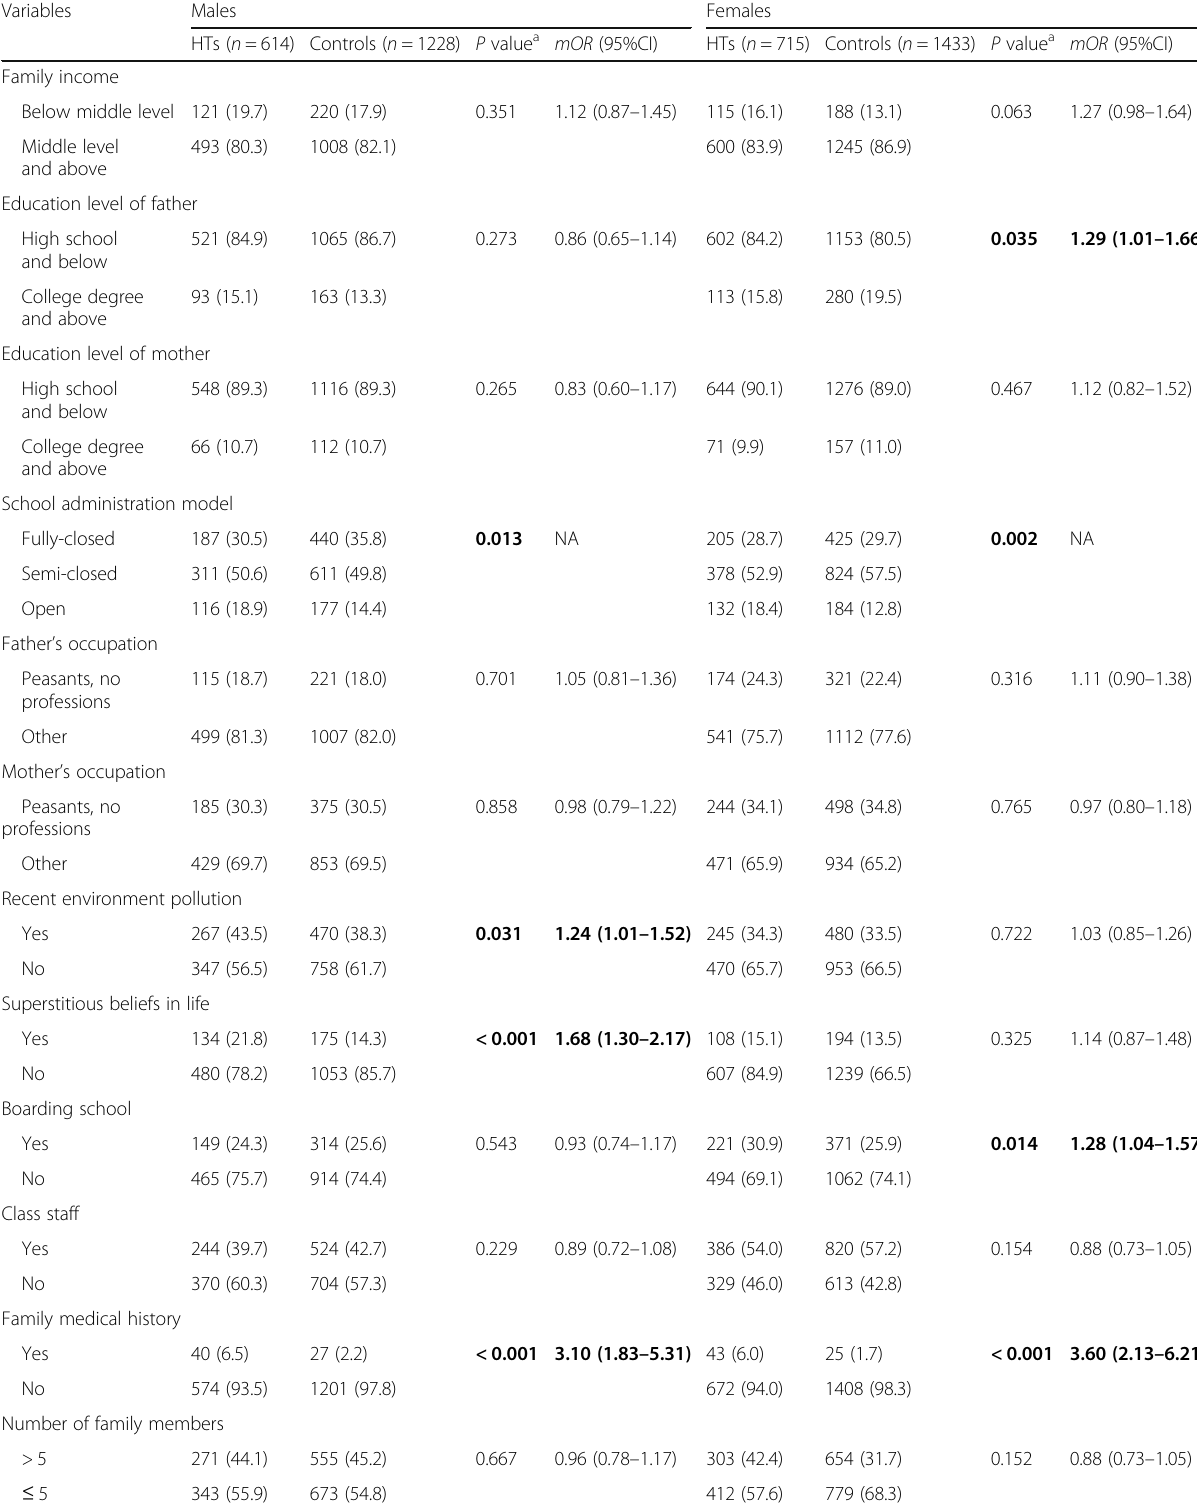
Table 2 Gender-specific for comparison of demographic characteristics between HTs and controls ( N = 3990) Variables